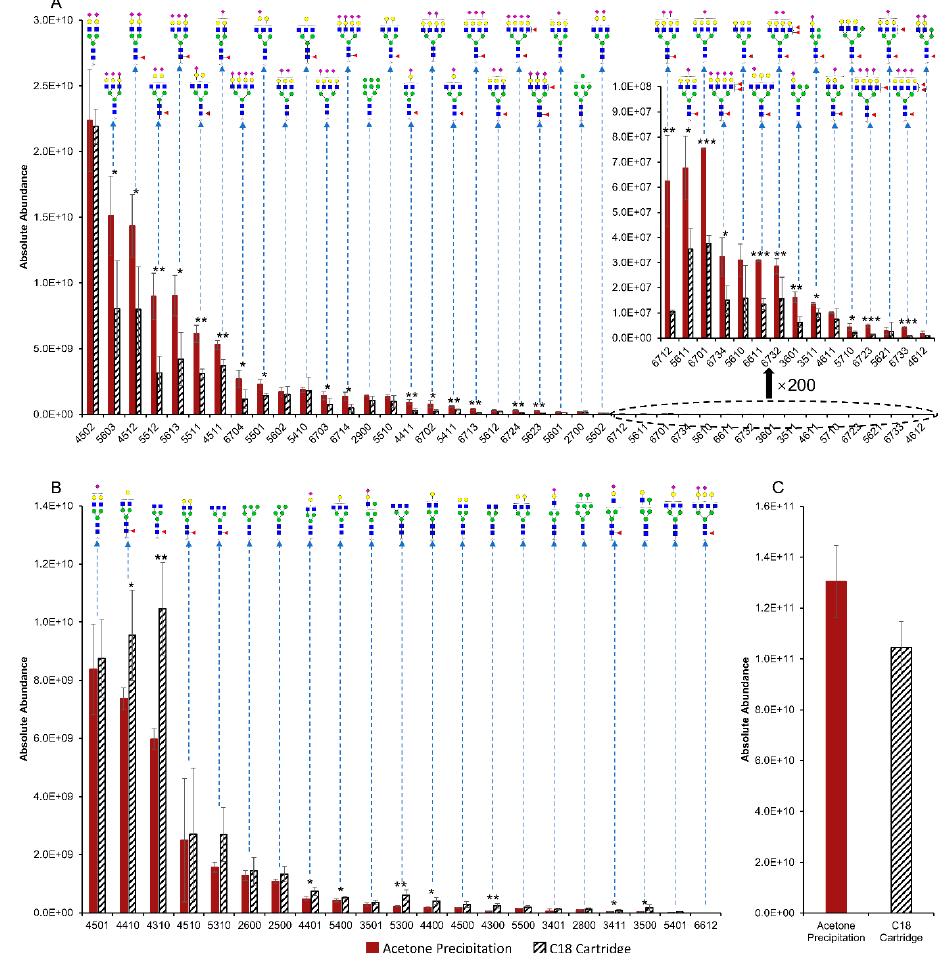
Figure 3. Comparisons of 61 N -glycan abundances from 1 µ L of human serum treated by acetone